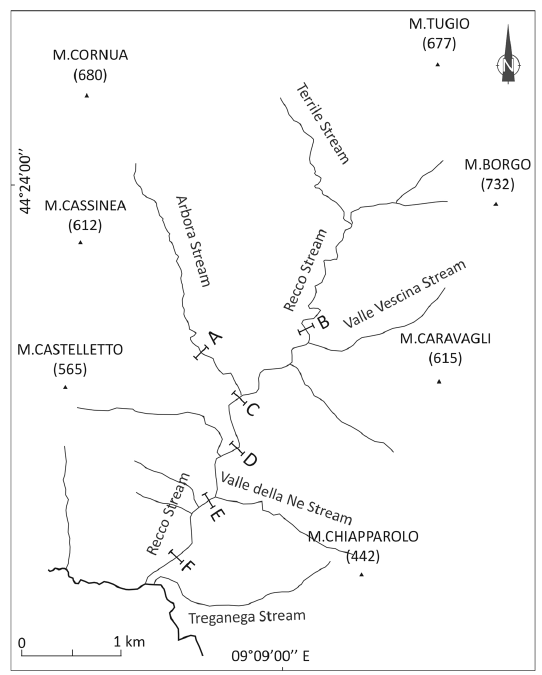
Fig. 1. Locations of cross sections in the Recco Stream channel